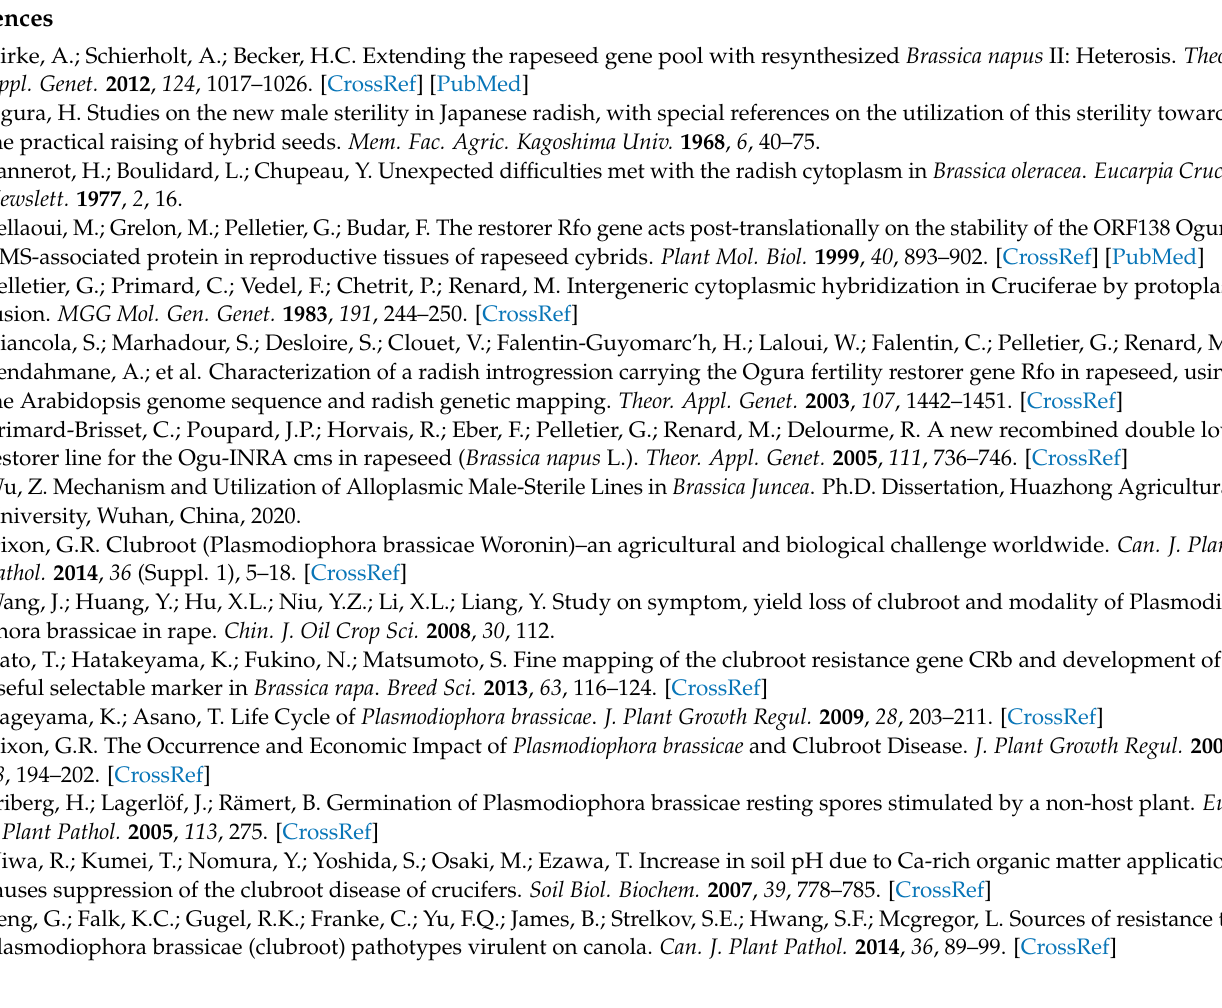
Table S2: Result statistics of prospect selection; Table S3: Result statistics of background selection; Table S4: Primers used in background selection; Table S5: Reaction systems for PCR